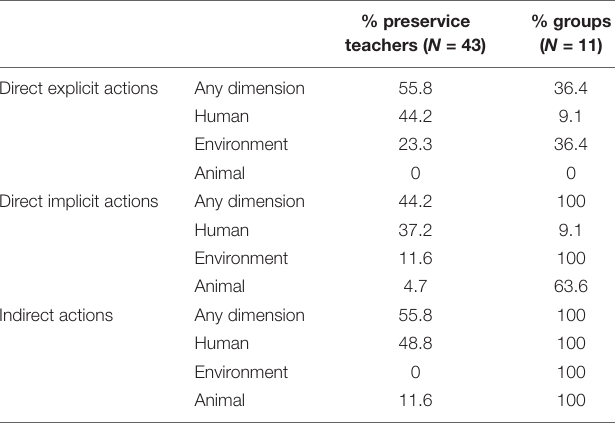
TABLE 2 | Percentage of preservice teachers and groups that proposed actions of each